Question: From the figure, is the trend upward or downward?
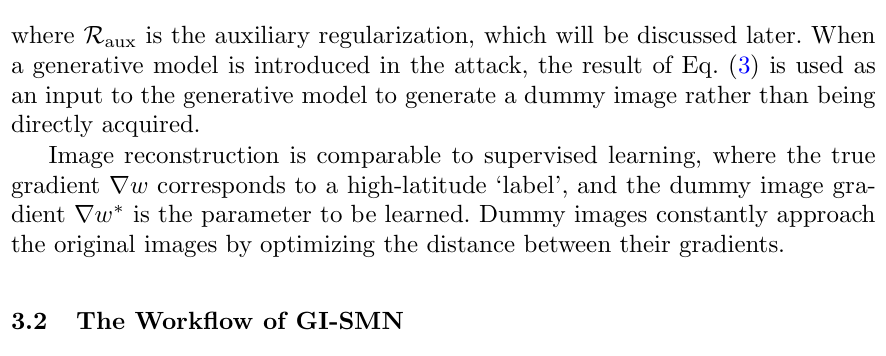
Answer: increasing